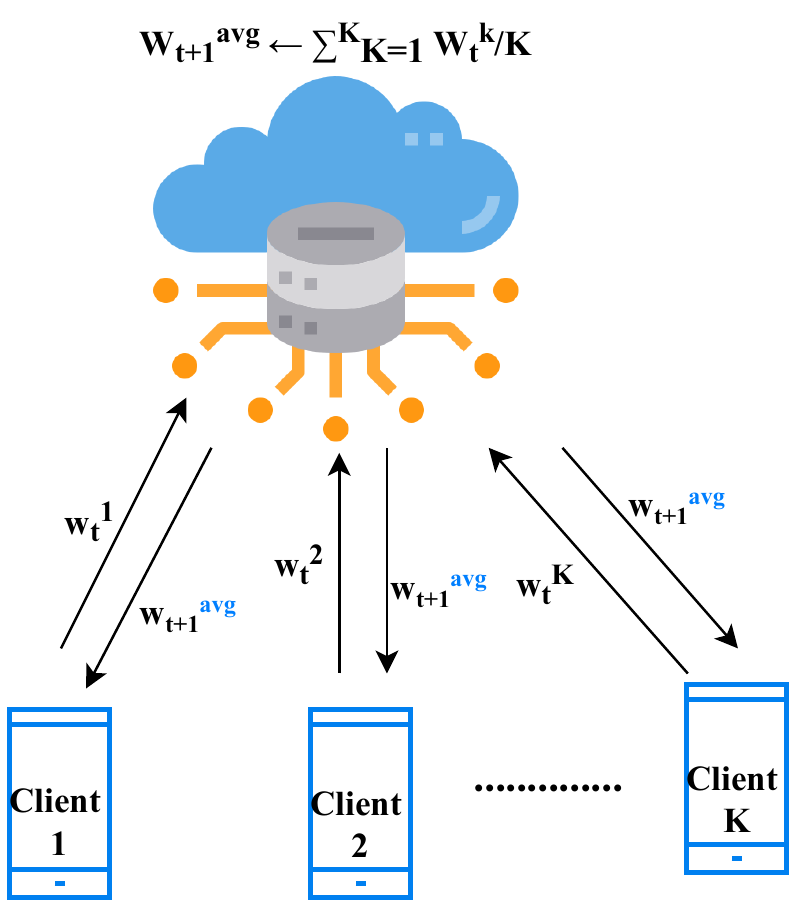
Figure 2. Federated Averaging Process. FL obtains the average of the w t value received from the client of K from the server and sends the updated w t + 1 back to the